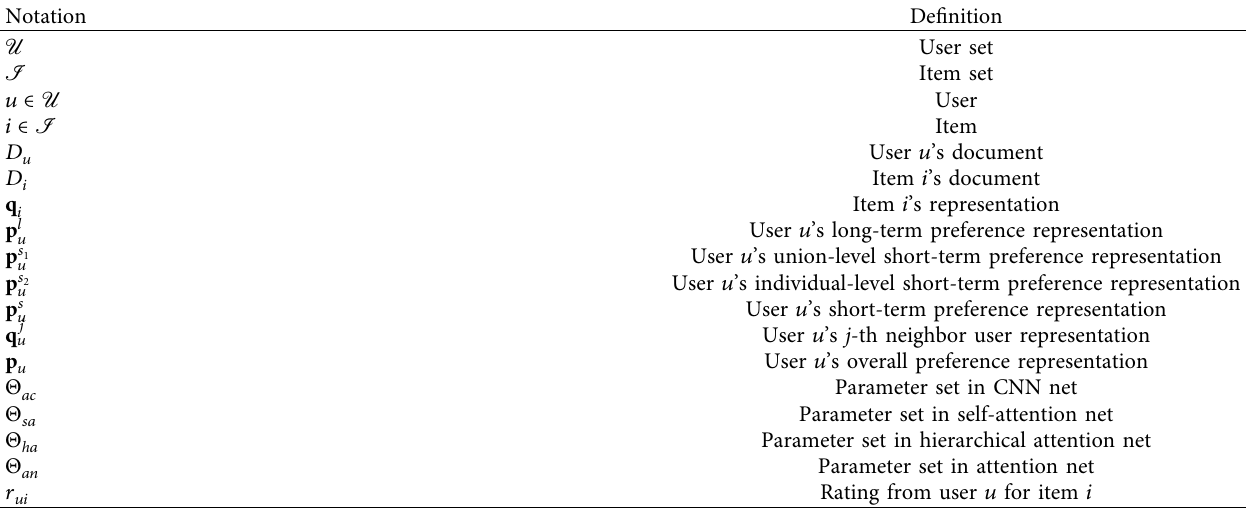
Table 1: Notations and their